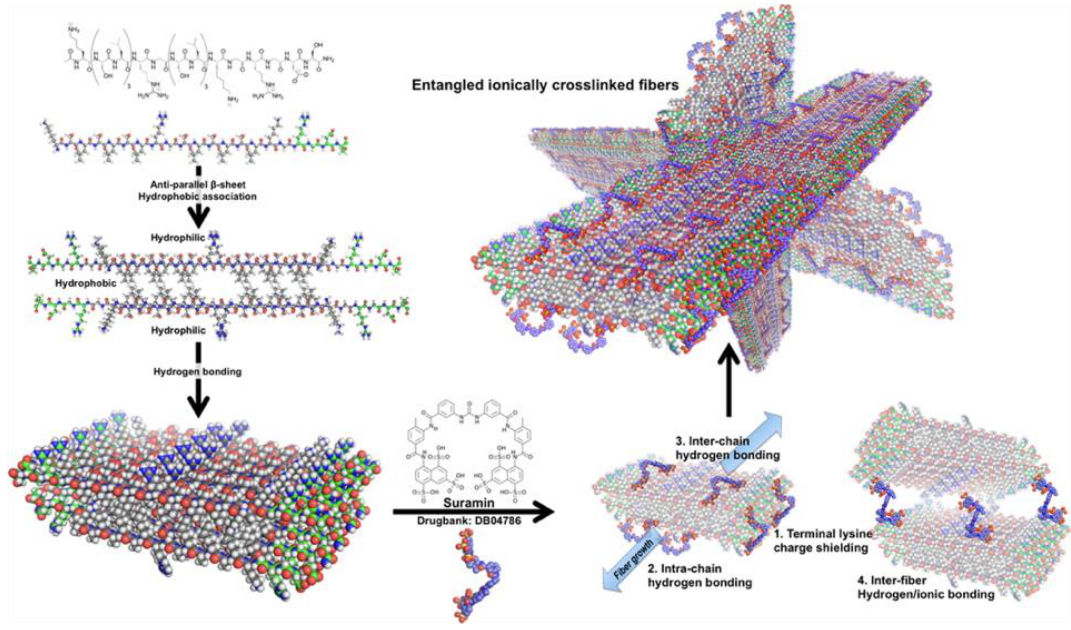
Figure 7. Schematic of molecular self-assembly of peptide fibers with an RGDS terminal sequence. Main SL-repeat regions arrange antiparallel to each other and hydrogen bond into sheets. Polyvalent suramin allows for intramolecular and intermolecular hydrogen bonding and ionic interaction with terminal lysines. Stabilized short fibers’ terminal charges allow fiber growth and polymerization into hydrogel networks. Reprinted with permission from Reference 49. Copyright 2015 American Chemical Society.